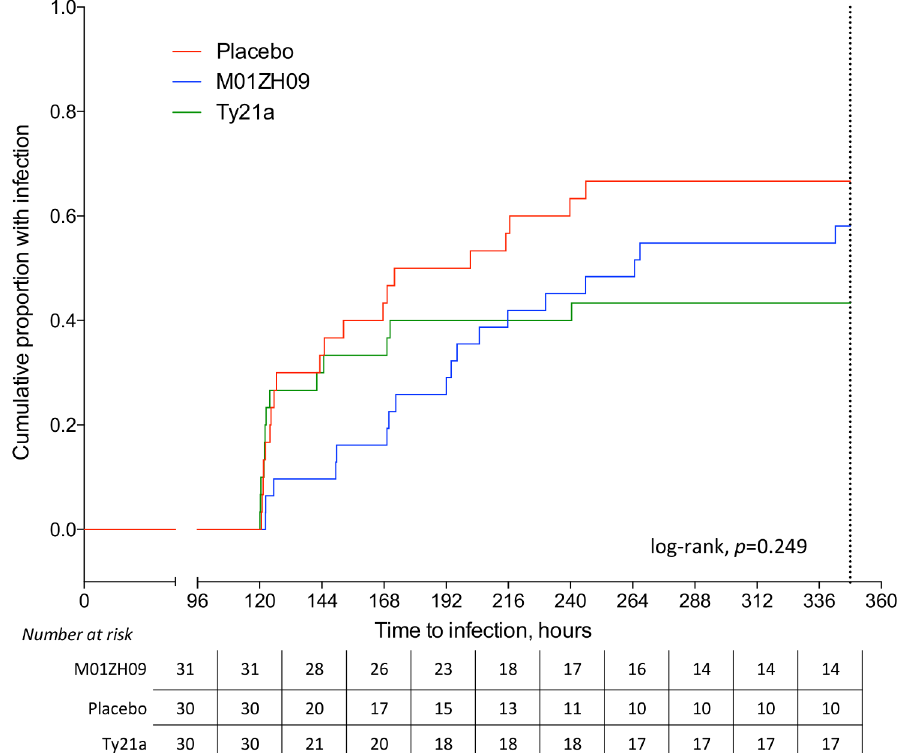
Fig 2. Cumulative incidence of typhoid infection after S . Typhi challenge at Time = 0. Time to infection, measured from challenge agent ingestion to development of first fever (cid:3) 38°C or first positive blood culture sampling. Non-diagnosed participants censored at 348 hours (dashed line). P value from log-rank test comparing all three